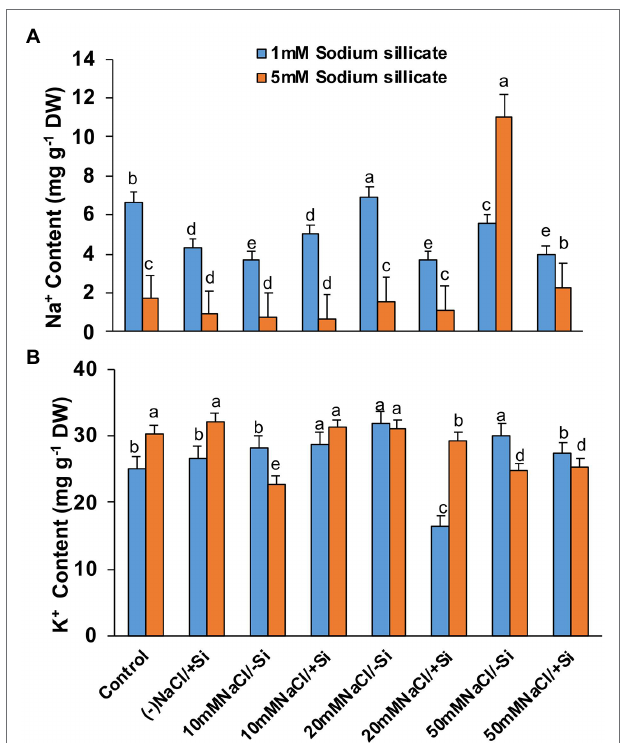
FIGURE 13 | Changes in (A) Na + content (B) K + of mung bean ( Vigna radiata ) under 1 mM (Si 1 ) and 5 mM (Si 2 ) Si supply and salinity stress after eight treatments: (i) control (T1), (ii) − NaCl+Si (1 mM/5 mM) (T2), (iii) 10 mM NaCl/ − Si (T3), (iv) 10 mM NaCl/+Si (1 mM/5 mM) (T4), (v) 20 mM NaCl/ − Si (T5), (vi) 20 mM NaCl/+Si (1 mM/5 mM) (T6), (vii) 50 mM NaCl/ − Si (T7), and (viii) 50 mM NaCl/+Si (1 mM/5 mM) (T8) for a period of 10 days. Vertical bars indicate Mean ± SE of the means for n = 4. Means denoted by the different letters are significantly different at p ≤ 0.05 according to the Tukey’s studentized range